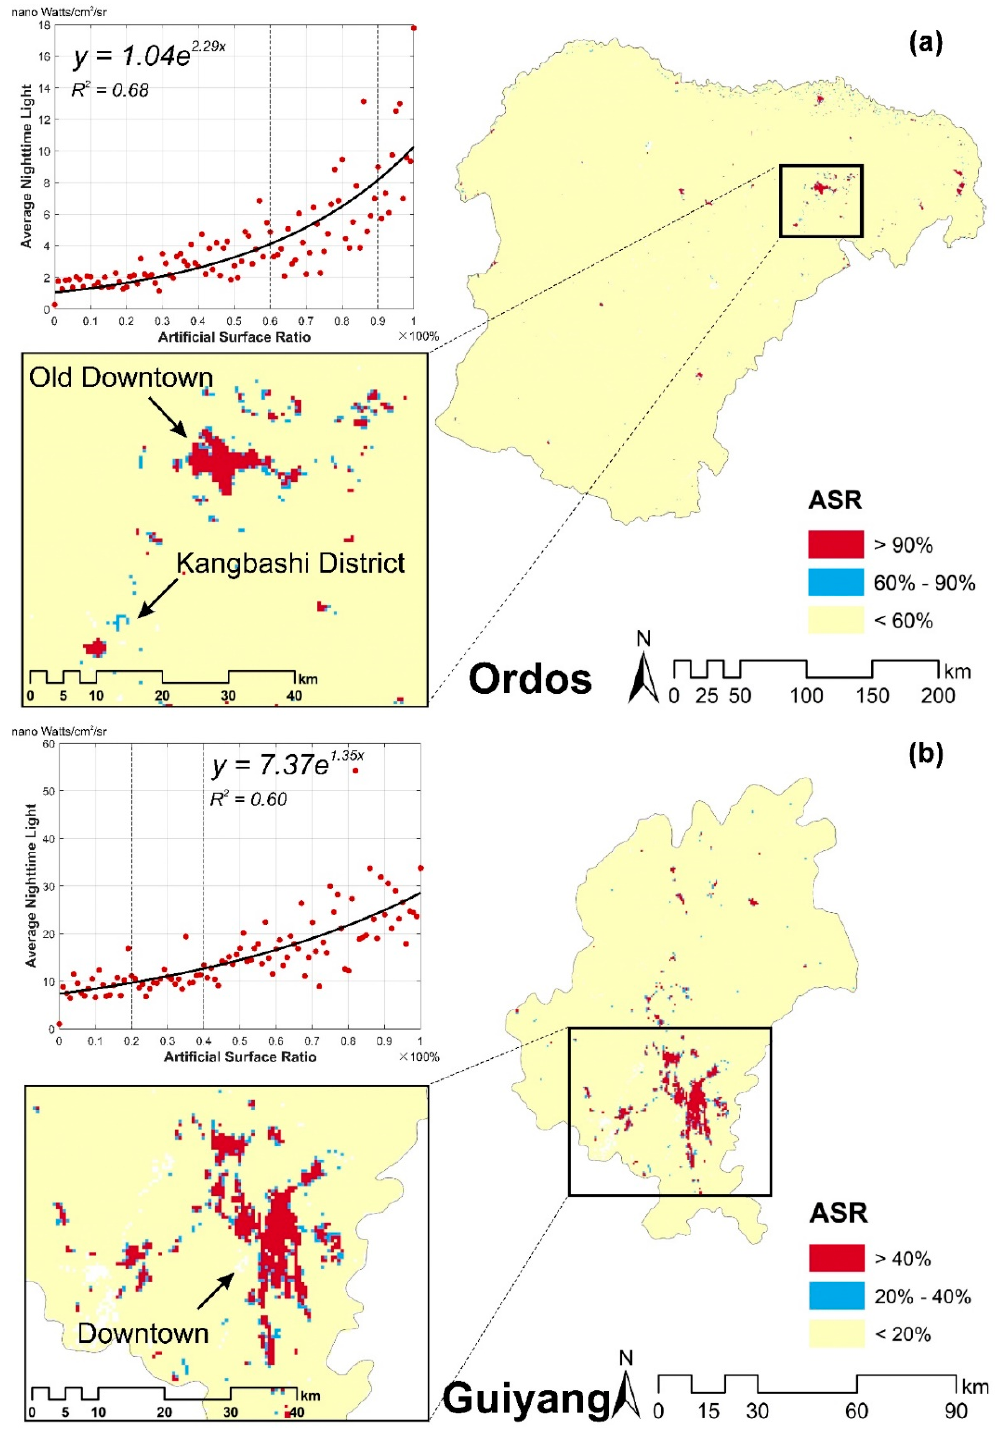
Figure 12. SSUDC and the spatial distribution of the artificial surface ratio of ( a ) Ordos and ( b ) Guiyang.